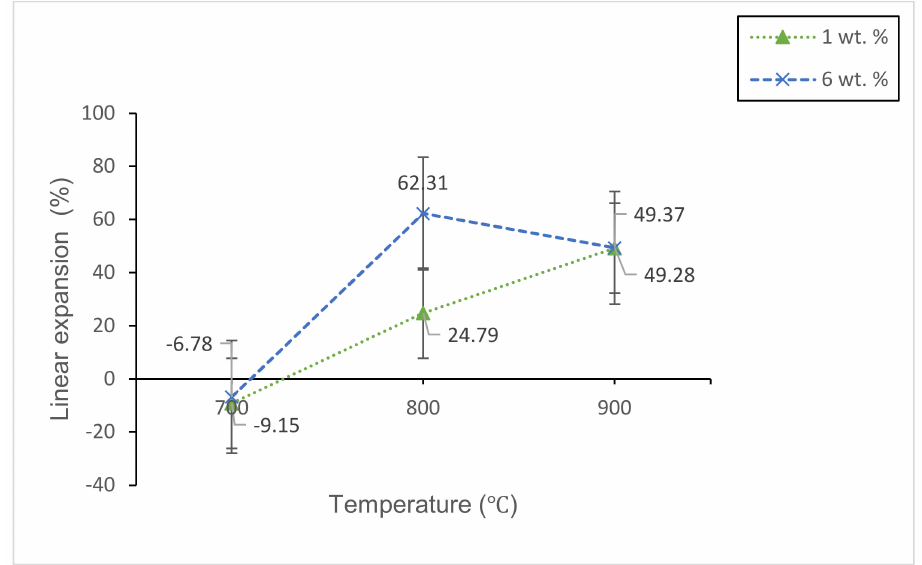
Figure 10. The linear shrinkage of 1 and 6 wt% samples sintered at various temperatures for 60 min.